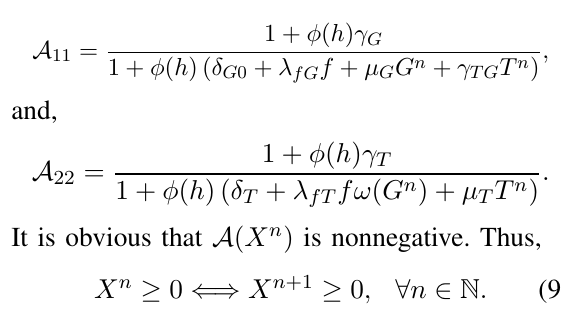
Fig. 8: Stability/instability of equilibria when R 01 < 1 and ω ( G e ) R 10 < 1 . Like in Fig 4 : (a) shows two stable equilibria: the stable grassland equilibrium and the stable woodland equilibrium (bistability). Fig 6 -(b) is different from Fig 4 -(b). Here, tree and grass coexistence does not occur; the woodland equilibrium is GAS. Then, the stable internal equilibrium disappears when ω ( G e ) R 10 < 1 . Thus trees dominate the vegetation. This situation does not occur when we use Holling type